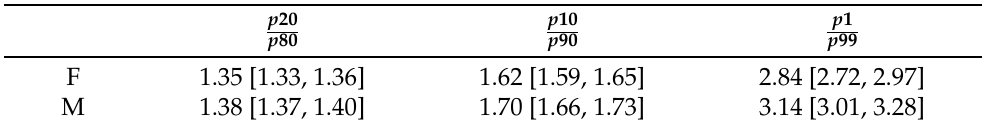
Table 6. ICE-Mortality gradient summarized as equivalent relative index of inequality for se- lect quantiles.